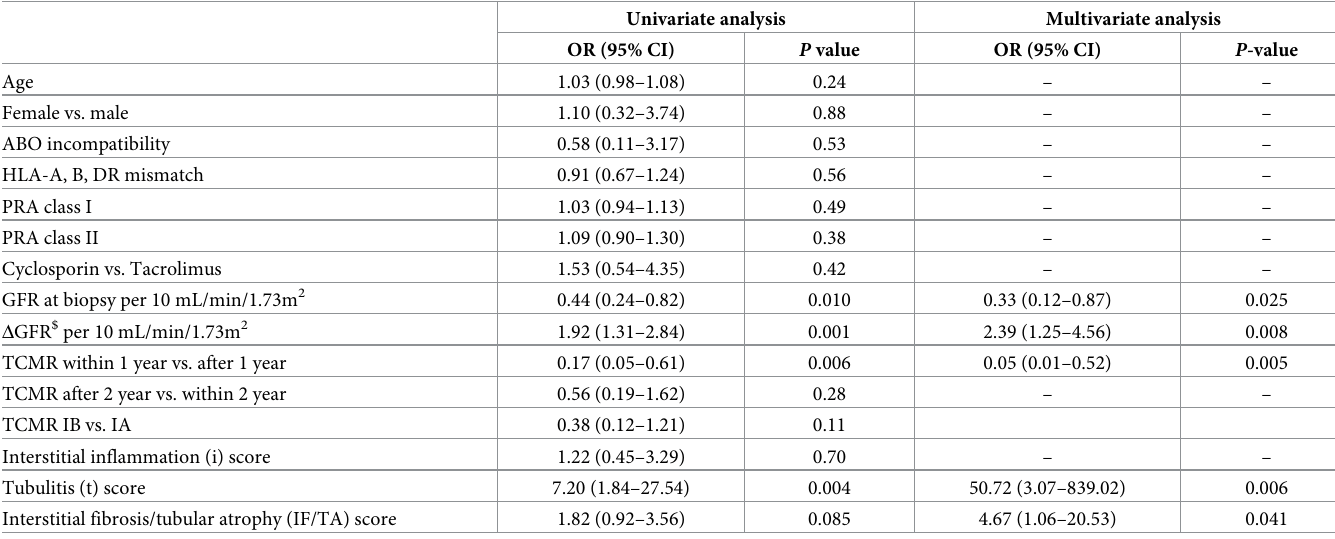
logic diagnosis of acute ABMR was closely correlated with the molecular diagnosis. However, all 4 cases of acute pure TCMR in histologic evaluation did not show any evidence of TCMR in MMDx. Therefore, clinicians treating patients who develop acute pure TCMR at one year after transplant in the pathological examination should consider the possibility of hidden ABMR or other causes of azotemia, especially when the patients are not responding well to steroid treatment. As TCMR remains a significant clinical subject in the aspect of a bidirectional relationship with ABMR, the concept of chronic active TCMR was introduced [7–9]. One report showed that concurrent acute TCMR in recipients with biopsy-proven ABMR was an independent risk factor for graft loss [9]. Another study suggested that persistent TCMR induced graft inter- stitial inflammation and fibrosis, thus leading to allograft failure [7]. Additionally, recent stud- ies have demonstrated a link between pure TCMR, the development of de novo DSAs, and late graft failure due to chronic active ABMR [18, 19]. In our study, four out of nine patients who experienced AMBR after rejection treatment developed de novo DSAs. Two patients recovered graft function after rejection treatment. In the other two patients, however, repeated AMBR Table 4. Risk factors associated with non-response to rejection